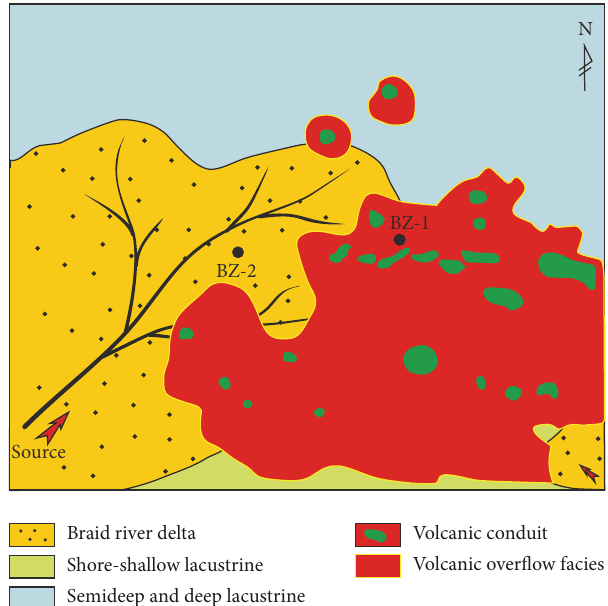
Figure 3: Sedimentary facies and volcanics distribution of the first and second members of Dongying Formation (E 3 d 1+2 ) based on the interpretation of well and seismic data. The mapping area is shown in Figure